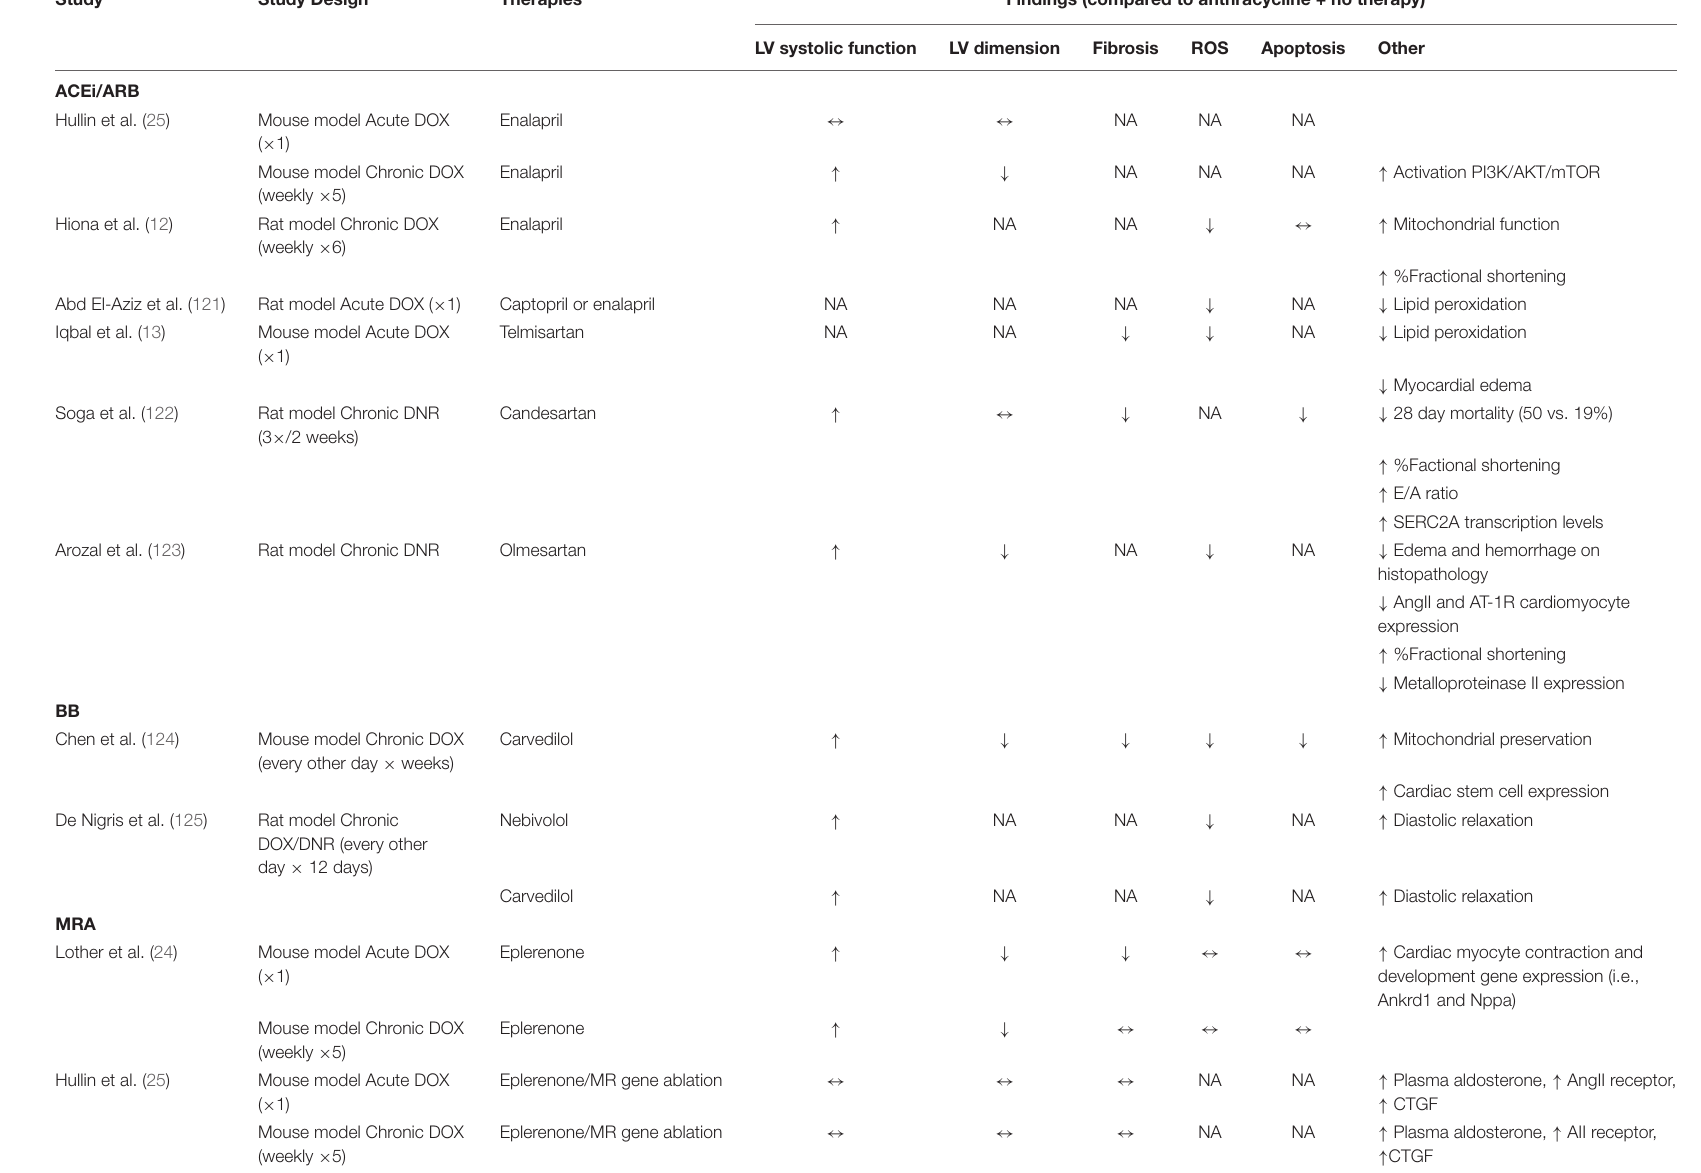
TABLE 1 | Description of example preclinical studies and summary of therapeutic effect on AIC